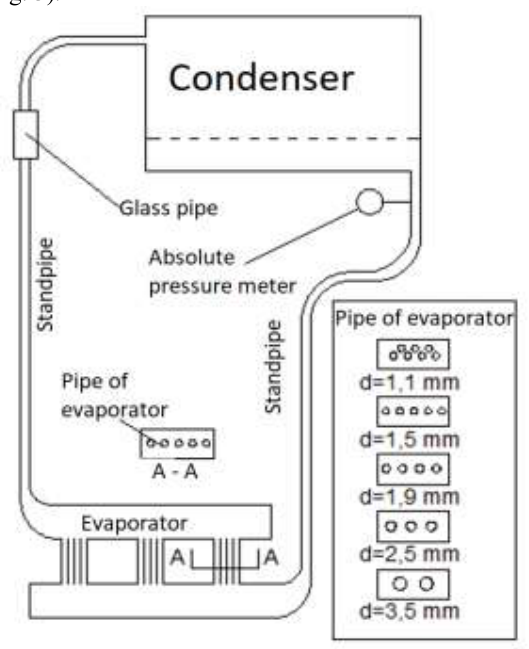
Fig. 3. Two-phase closed loop heat pipe [3].